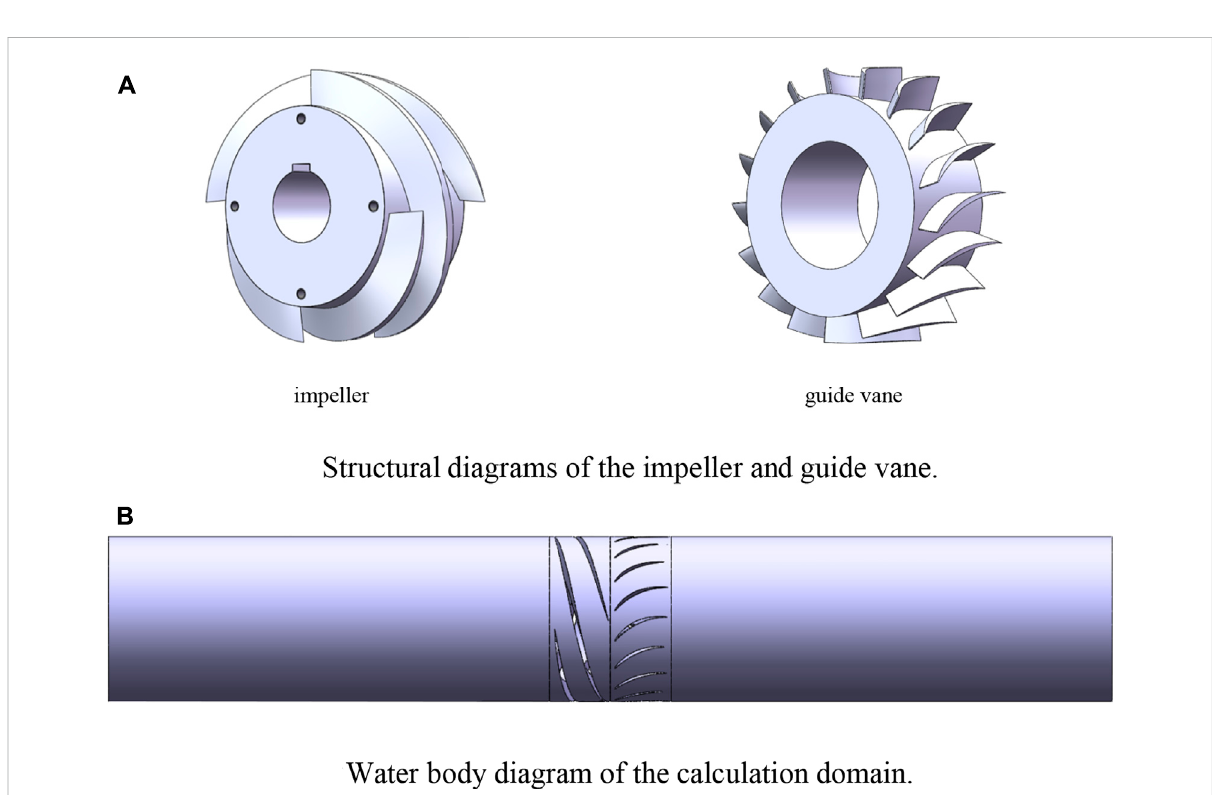
FIGURE 2 Three-dimensional rendering. (A) Structural diagrams of the impeller and guide vane. (B) Water body diagram of the calculation